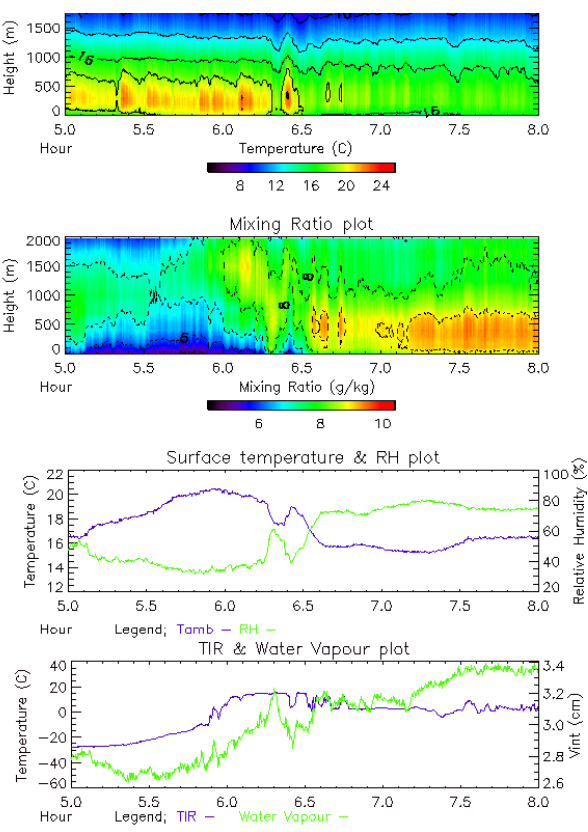
Fig. 1. Microwave radiometer retrieval showing temperature, mass mixing ratio, -height cross sections for 0–2km height, 24 June 2005, 05:00–08:00UTC. Time series of surface temperature and relative humidity, integrated water content and infrared temperature are also